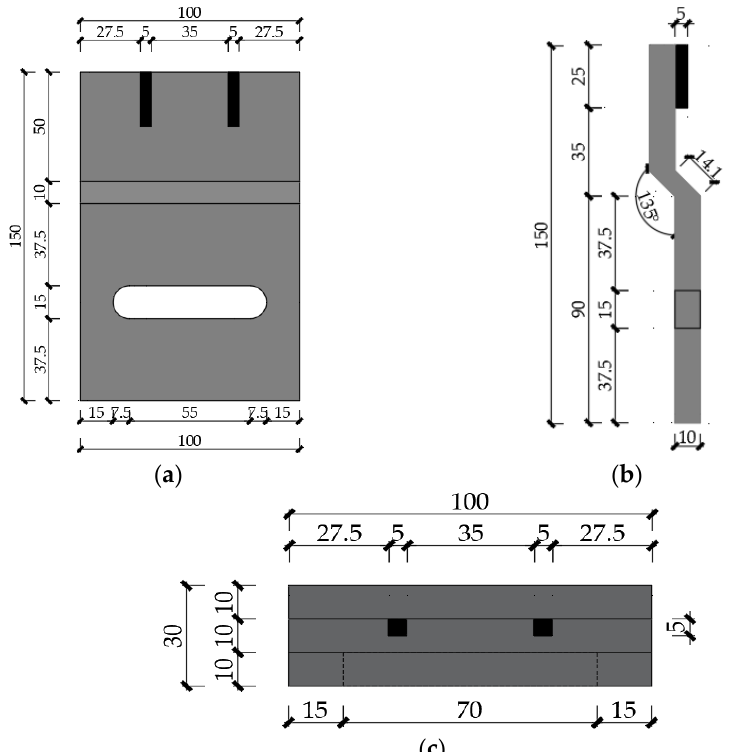
Figure 3. Connector installation dimension schematic (units: mm).